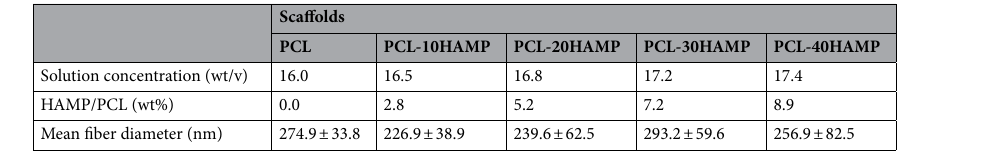
Table 2. The mean fiber diameter of the